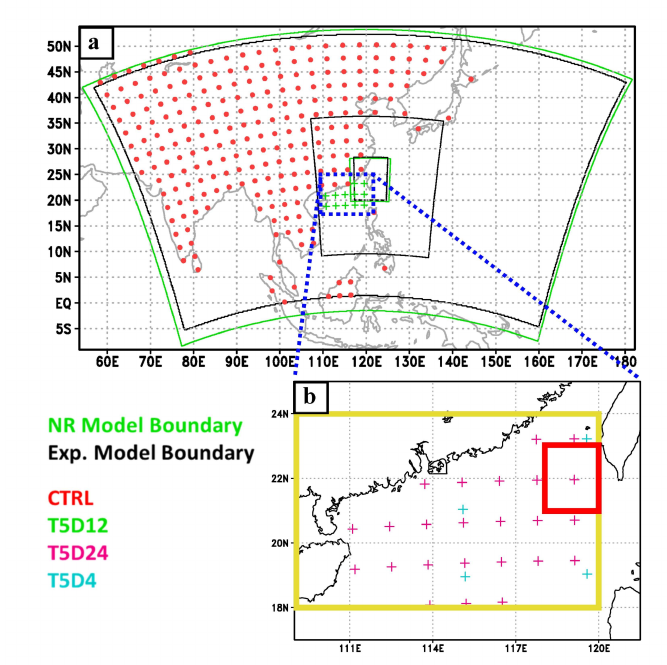
Figure 3. ( a ) Domain settings for the NR (green line) and the experimental runs (black line). Red dots/green crosses show locations of synthetic sounding/dropsonde observations used in T5D12. ( b ) Magenta/cyan crosses denote locations of synthetic dropsondes used in T5D24/T5D4. The red and yellow boxes represent the areas of average